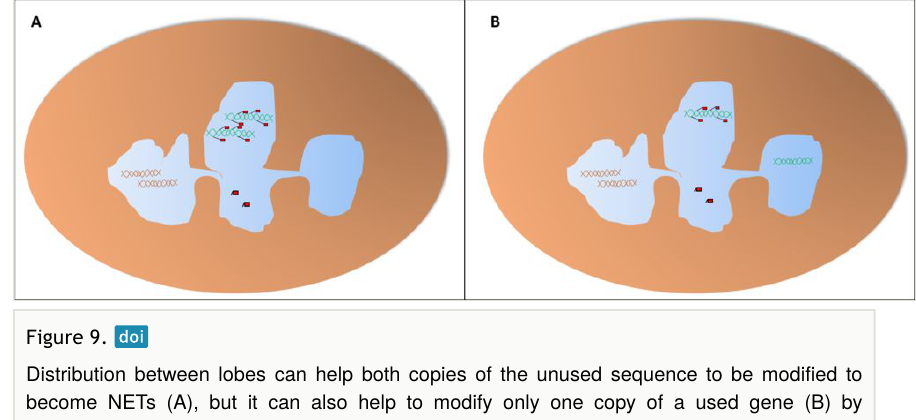
Distribution between lobes can help both copies of the unused sequence to be modi fi ed to become NETs (A), but it can also help to modify only one copy of a used gene (B) by containing the modifying enzymes in one lobe and keeping a functional copy of the gene for normal transcription.